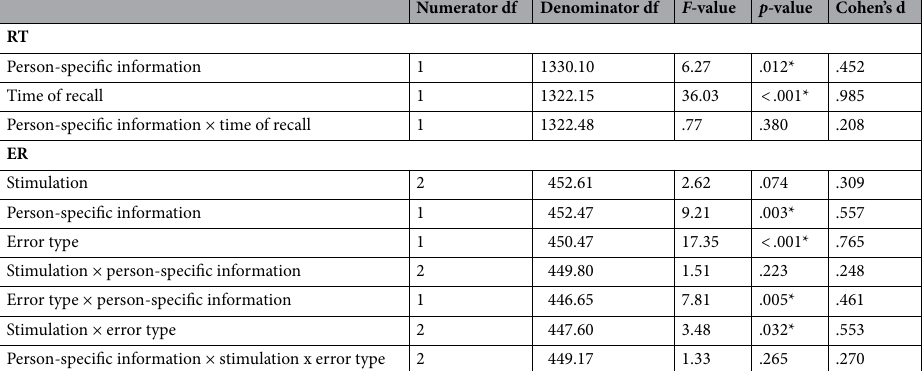
Table 1. Results of the linear mixed (reduced) model (LMM) performed on the reaction time (RT) and error rate (ER) in Experiment 1. In the models, each participant was treated as a random factor (random intercept model). The within-subjects factors stimulation (anodal, cathodal and sham), person-specific information (surnames, professions), and time of recall (early, late) were treated as fixed-effect covariates for the RT model. For the ER model, the factor time of recall was replaced by error type (intrusions, omissions). Asterisks indicate significant results ( p < 0.05). df, Degrees of